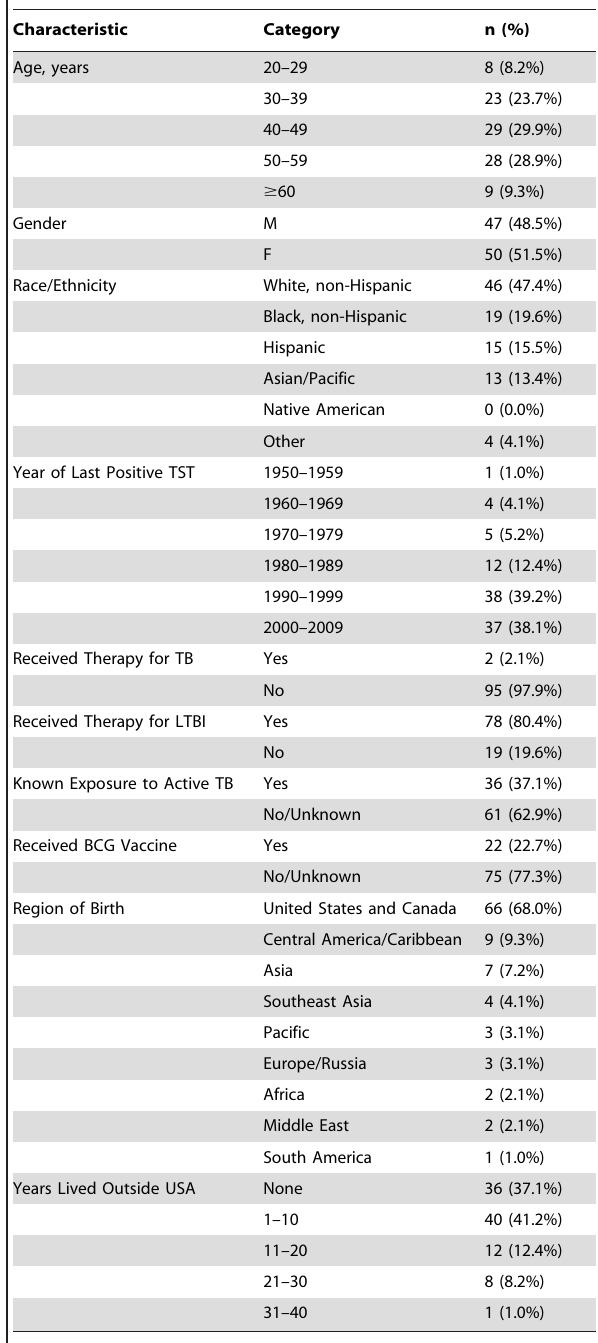
Table 1. Subject